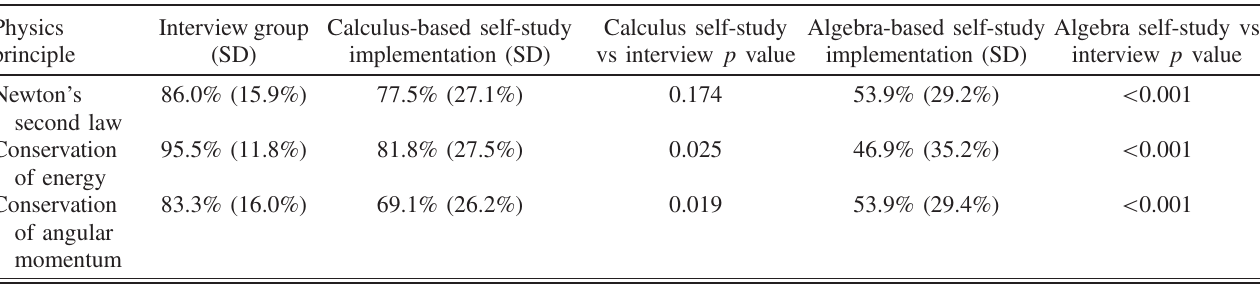
TABLE IV. Comparison of the average paired problem scores and standard deviations for students in the one-on-one interview group as compared to those who made use of the tutorial in the large enrollment classes in the self-study